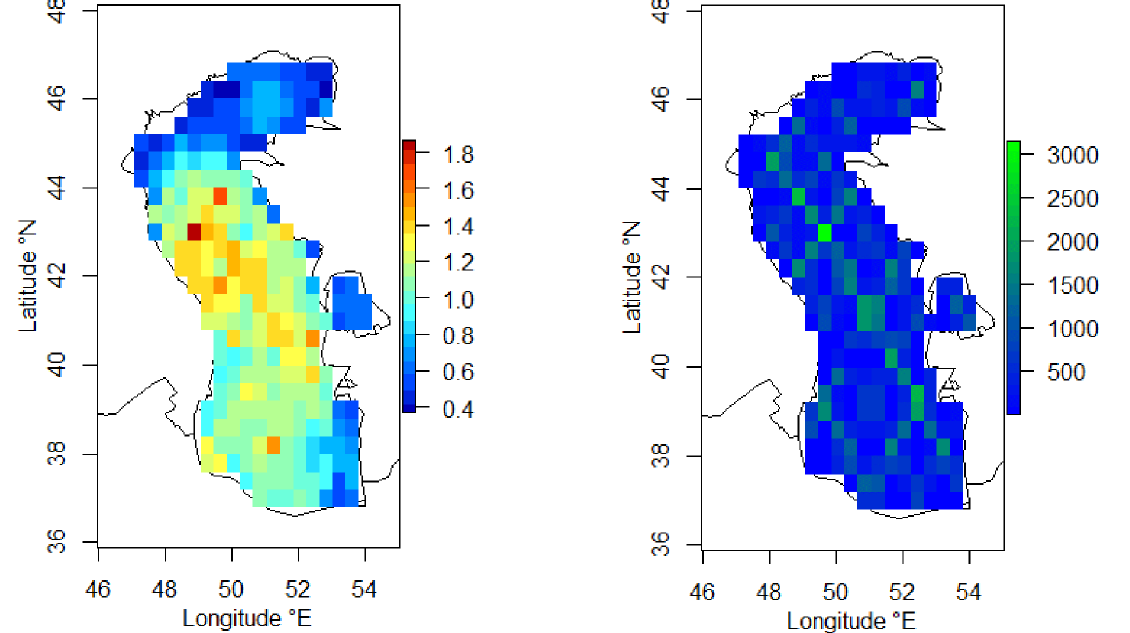
Fig. 7. Average significant wave height ,sat S H (m, colour scale) in the Caspian Sea in 2002–2013 from JASON-1 satellite altimetry (left), and the number of satellite measurements per grid cell (right). The pixel size is 0.4   0.4  (18  25 pixels